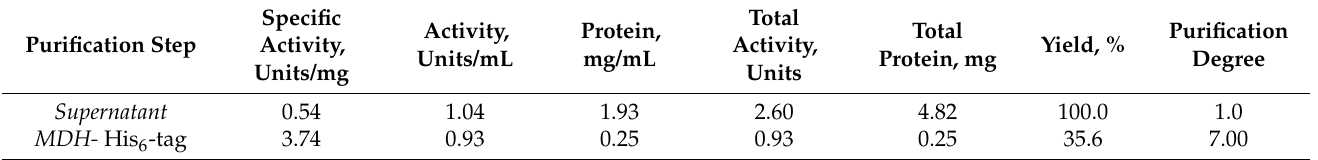
Table 1. Purification of MDH-His 6 -tag from M. extorquens pCM160::mxaF_M.ext.